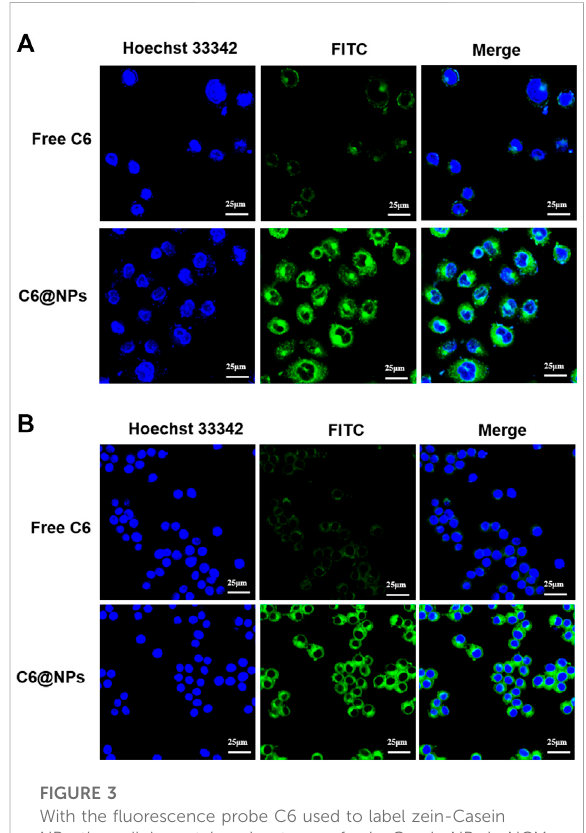
FIGURE 3 With the fl uorescence probe C6 used to label zein-Casein NPs, the cellular uptake advantages of zein-Casein NPs in NCM 460 cells (A) and Raw 264.7 cells (B) were investigated by CLSM, after 4 h incubation with the C6 concentration of 100